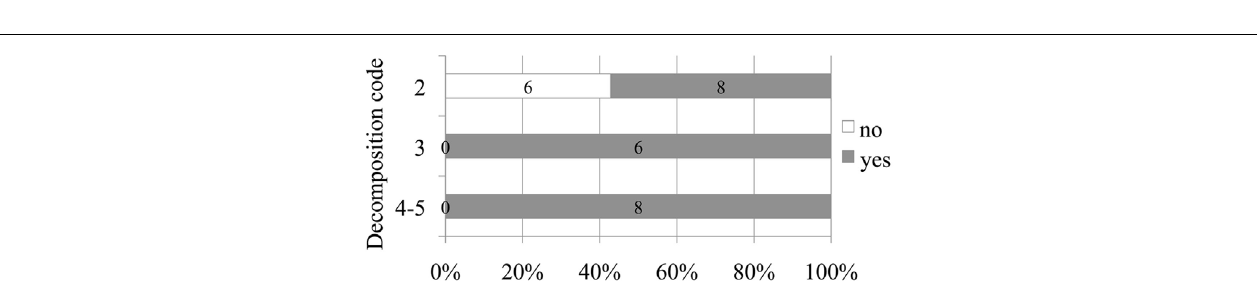
FIGURE 3 | Number and relative percentage of deep diving animals in which bubbles were observed (in dark gray) compare to those in which bubbles were absent (in white) attending to decomposition code.